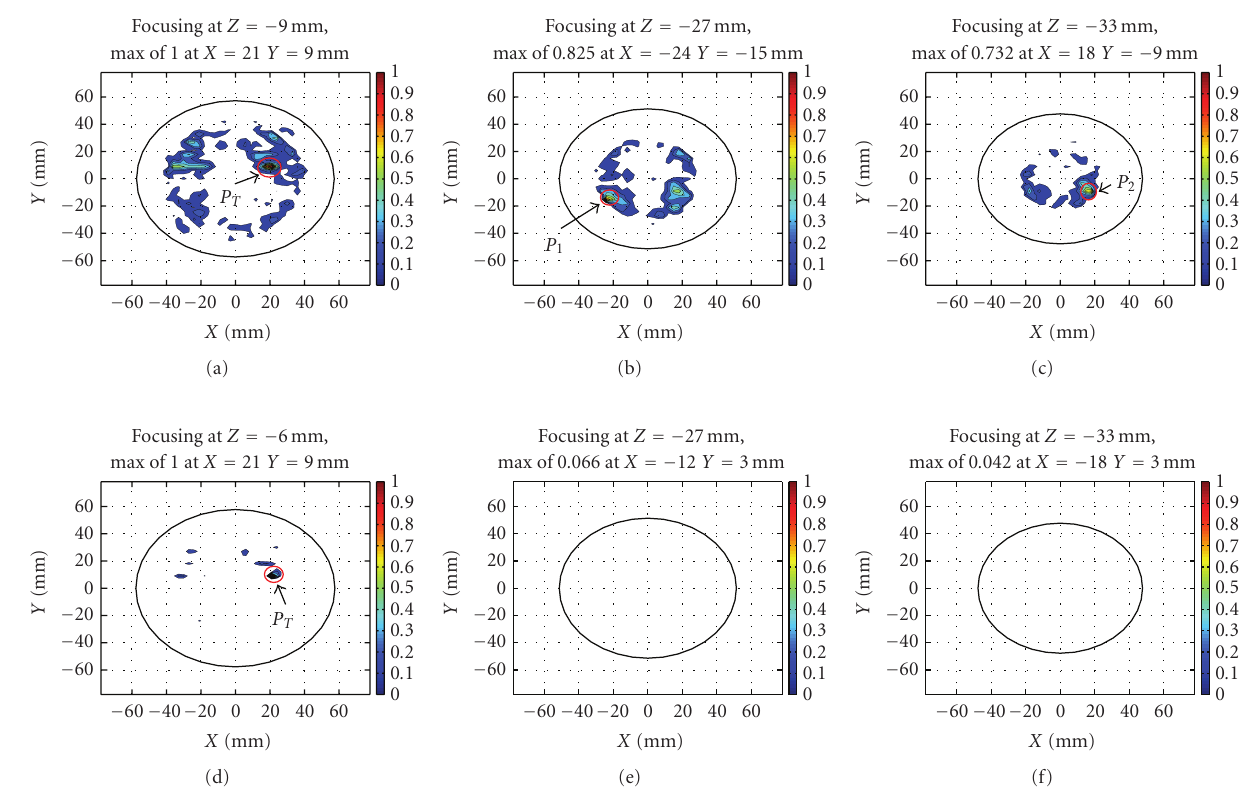
Figure 7: 2D focusing results for standard and improved DAS algorithms, for di ff erent horizontal planes along the z -axis: (a) standard DAS ( z = − 9), (b) standard DAS ( z = − 27), (c) standard DAS ( z = − 33), (d) improved DAS ( z = − 6), (e) improved DAS ( z = − 27), (f) improved DAS ( z = − 33). 2D contour plots show signal energy on a linear scale, normalised to the maximum in the 3D volume; values below 0.1 are rendered as